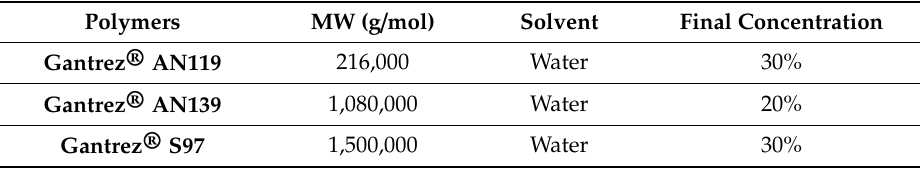
Table 1. Gantrez ® AN polymers used in this work. Polymers MW (g / mol) Solvent Final